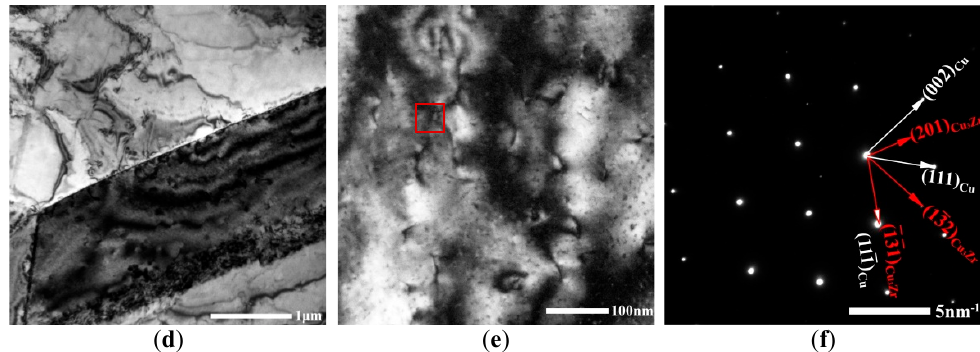
Figure 4. TEM images after ageing at 450 °C under different holding times: ( a ) 15 min; ( b ) 30 min; ( c ) 60 min; ( d ) 90 min; ( e ) 120 min; ( f ) SAED of the square area in ( e ). Table 2. Lattice distortion and dislocation density after ageing at 450 °C under different holding times.